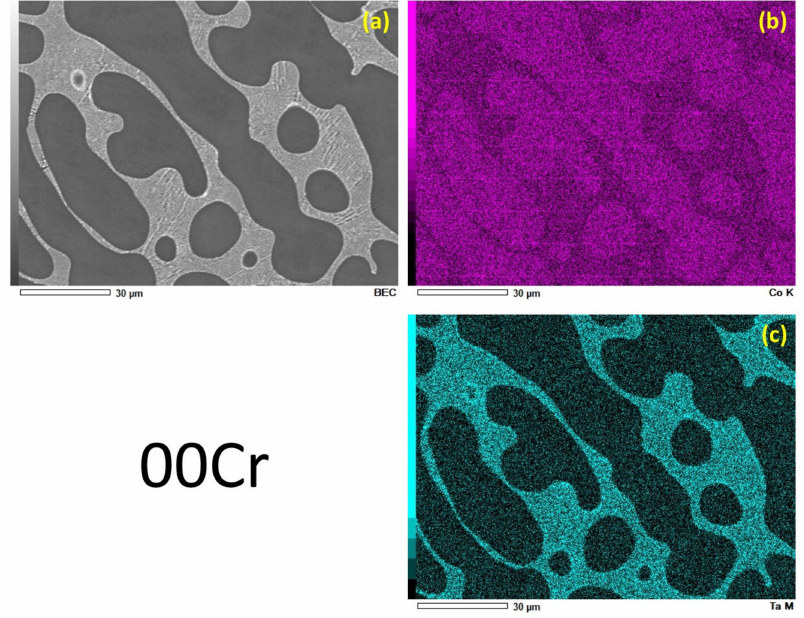
Figure 5. EDS X-cards (SEM/BSE: ( a ), Co: ( b ), Ta: ( c )) illustrating the element repartitions in the microstructures of the two alloys with finely structured (matrix + TaC) eutectic compounds (here: the 00Cr alloy).